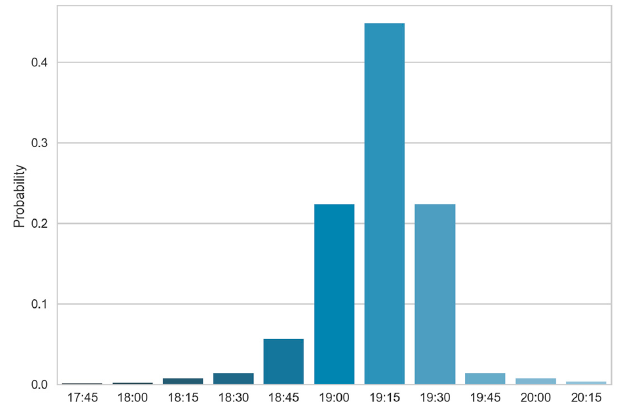
Figure 6. Probability density of the arrival time of an EV at the ArenA.